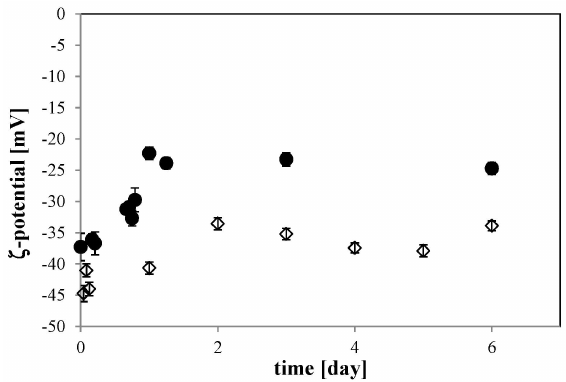
Figure 7. Time dependence of the ζ -potential of the O 2 MNB solution including 10 mM NaCl (solid circle) and no additives (open diamond). Each error bar shows the standard deviation of the